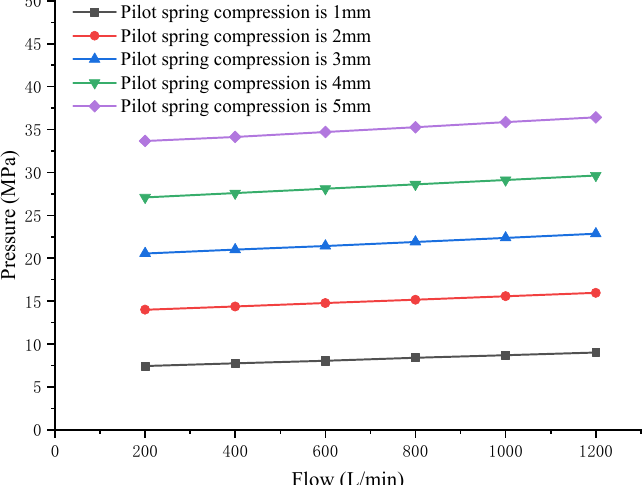
Figure 3. Working pressure variation curves of digital relief valve under different spring compressions and flow levels.